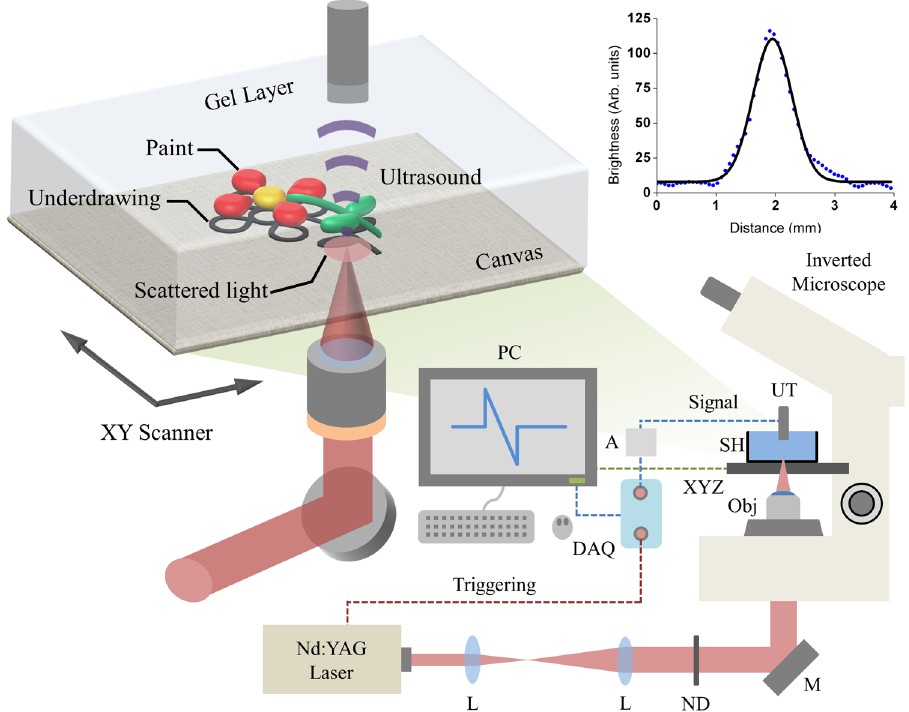
Figure 1. Photoacoustic imaging apparatus and sample configuration. Abbreviations: L, Lens; ND, Neutral density filters; M, Mirror; Obj, Objective lens; SH, Sample holder; XYZ, 3D translational stage; UT, Ultrasonic transducer; A, Amplifier; DAQ, Data acquisition card; PC, Recording computer. Inset shows the lateral profile of the irradiating beam on the canvas surface (dots: experimental points, solid line: fit to a Gaussian; R 2 =